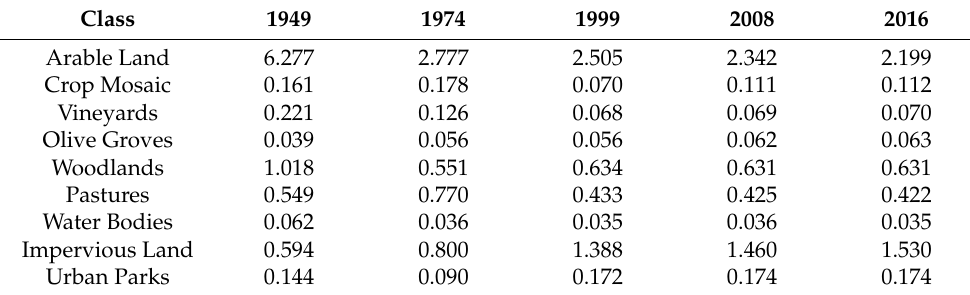
Table 1. Per-capita surface area (hectares) by land-use class in Rome, 1949–2016.